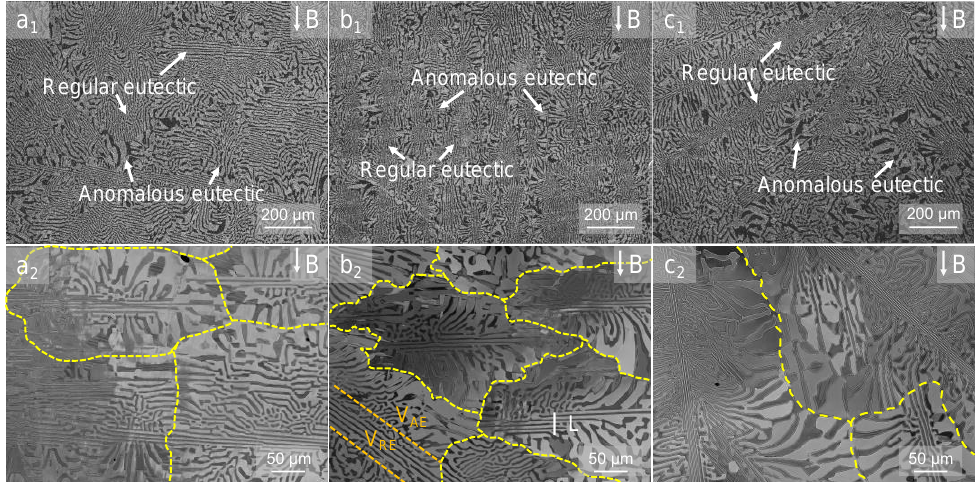
Figure 6. The cross-section SEM back-scattered electron images paralleled to the external magnetic field B. ( a 1 , a 2 ) 0 T sample; ( b 1 , b 2 ) 5 T sample; ( c 1 , c 2 ) 10 T sample. The dashed-yellow lines show the boundaries of the eutectic colonies. The solid white line in ( b 2 ) show the whole thickness of several lamellae, then the interspace of lamellae could be calculated by aforementioned line intercept method by Equation 1.